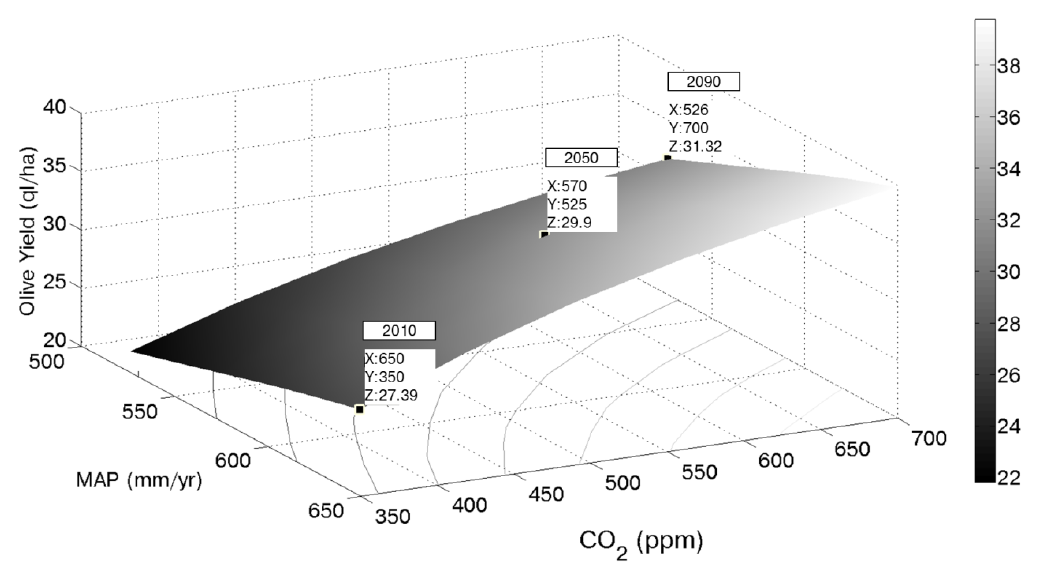
concentration and mean annual 2